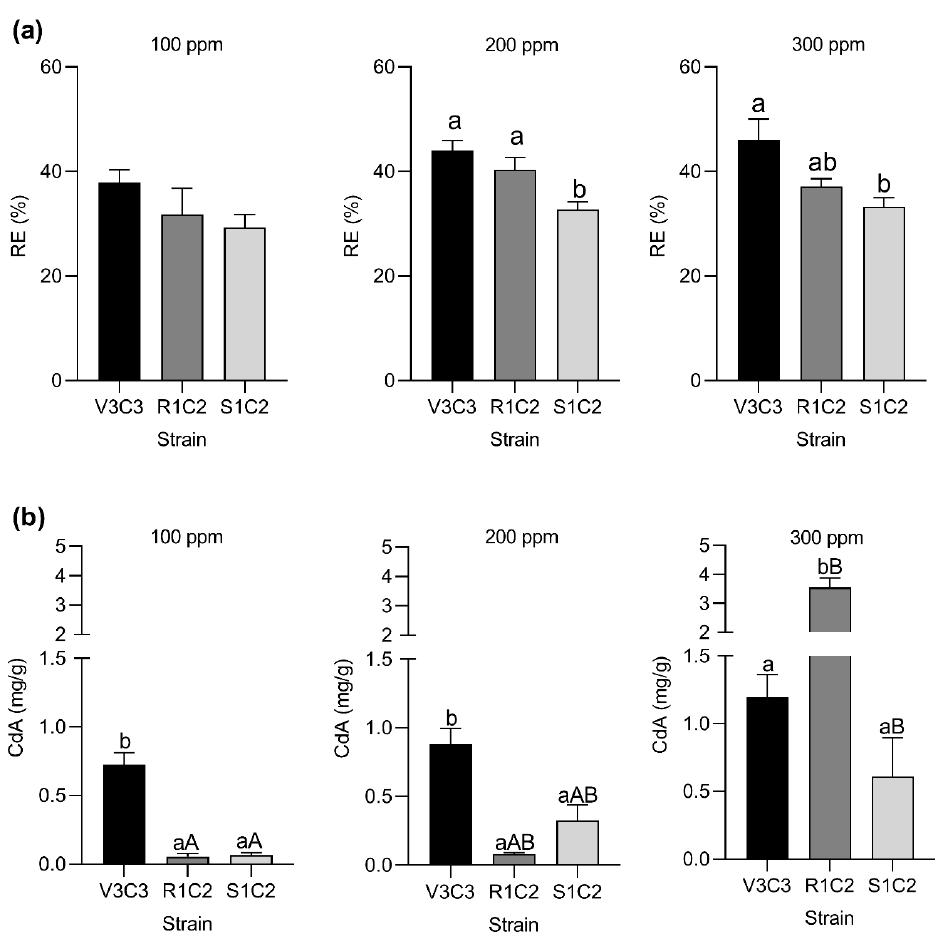
Figure 4. Removal efficiency and intracellular accumulation of cadmium by hypertolerant bacteria. The HCdB strains were cultured in LB medium at 0, 100, 200, and 300 ppm of CdCl 2 . Both, removal efficiency ( a ); and intracellular cadmium accumulation ( b ) were measured by Cd 2+ quantification. The bars represent the means of 3 replicates ± SE. Data were analyzed by ANOVA followed by Tukey’s multiple-comparison test. Different letters indicate statistically significant differences ( p ≤ 0.05). Lowercase letters represent comparisons between strains for each culture condition, while capital letters represent statistical comparisons for CdA among increasing concentrations for each strain in both RE (%) and CdA. The graphics were performed using GraphPad software v.8.0.1 by Dotmatics, San Diego, CA, USA.